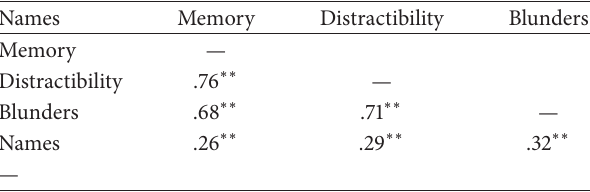
Table 3: Correlations between cognitive failure